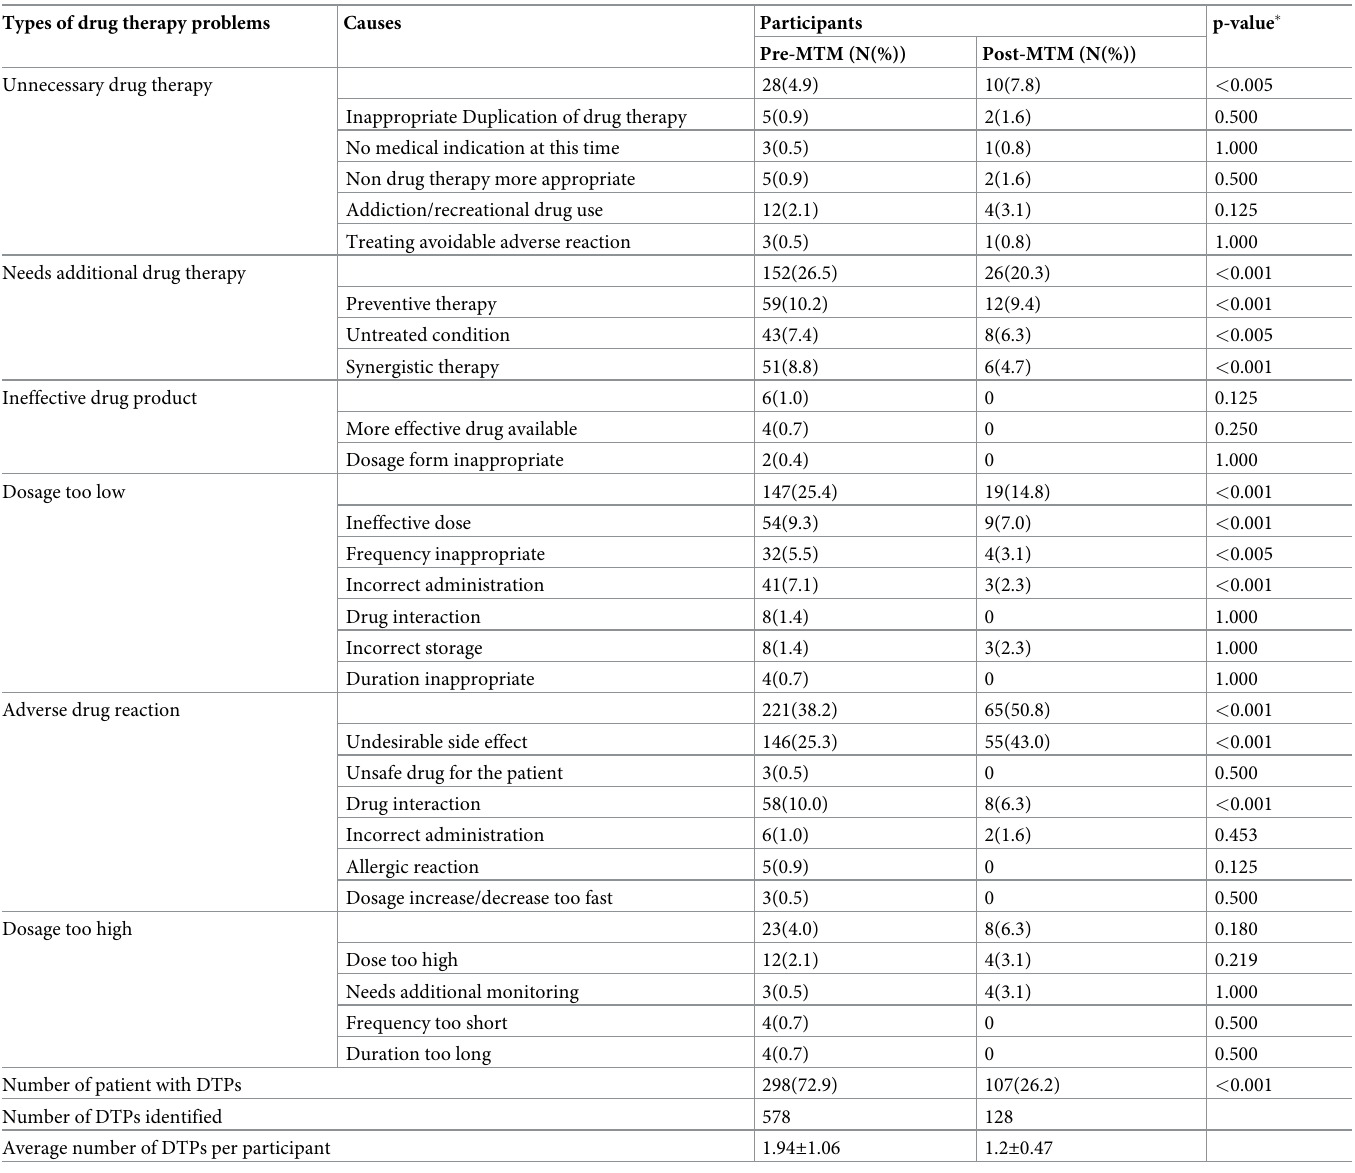
Table 3. Drug therapy problems and causes among adult patients with diabetes. Types of drug therapy